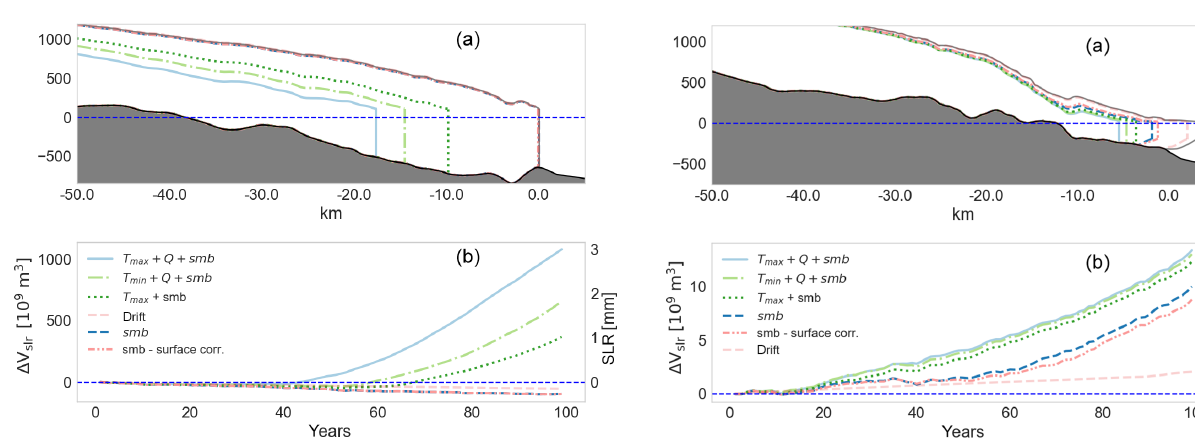
Figure 9. (a) King Oscar Glacier with a representative medium- SLR retreat scenario applying forcing factors as subglacial dis- charge Q , ocean temperature T , and surface mass balance SMB with and without accounting for surface elevation correction (SMB − surface corr.) for the medium-SLR scenario. The corresponding SLR of each experiment is displayed in panel (b) .